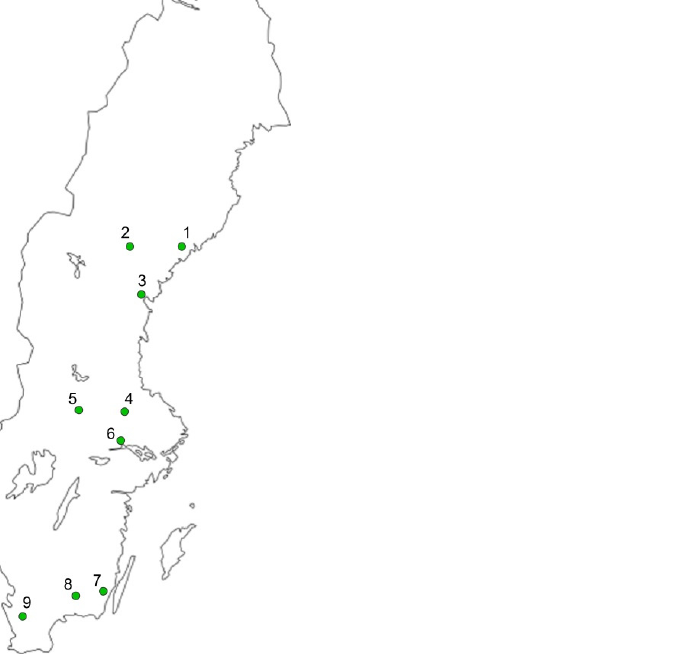
Figure 1. Map of Sweden showing geographical distribution of forest nurseries of the present study. Forest nurseries are numbered as in Table 1.